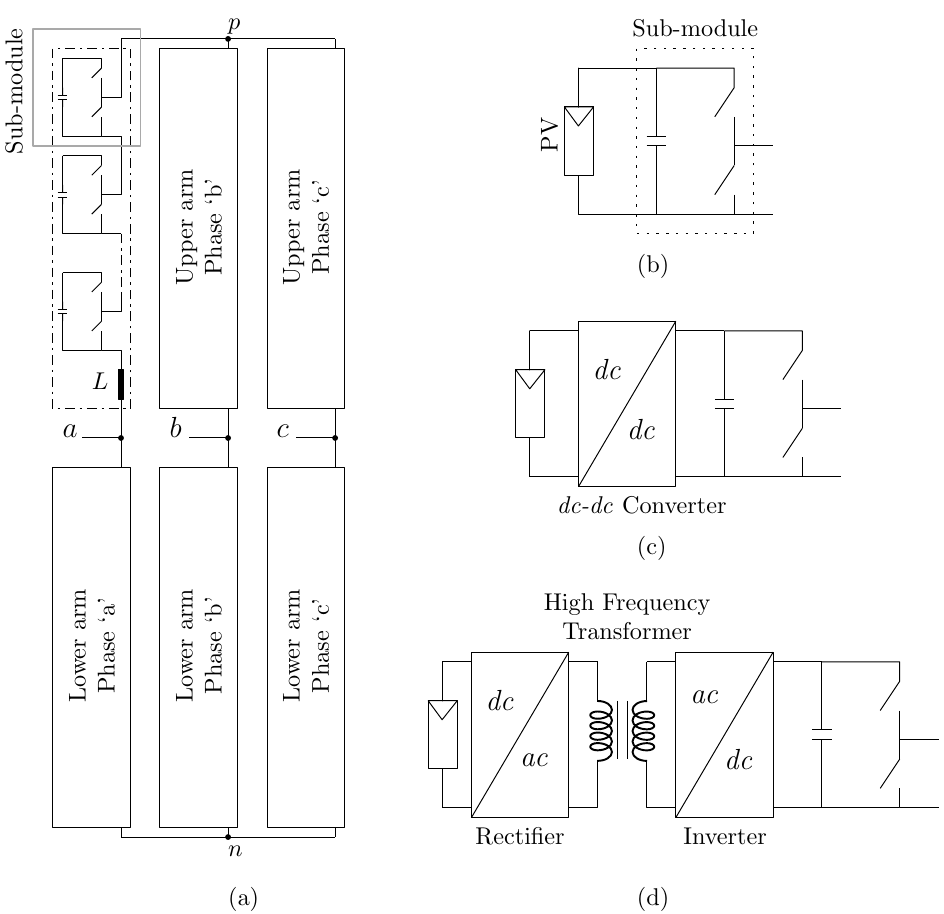
Figure 1. The Modular Multilevel Converter (MMC) and sub-modules with photovoltaic (PV) panels. ( a ) Three-phase MMC indicating the upper and lower arms and the sub-module, ( b ) the HB sub-module with direct connection of the PV panel, ( c ) the PV is connected to the sub-module using a non-isolated dc-dc converter, and ( d ) the PV is connected to the sub-module using a isolated